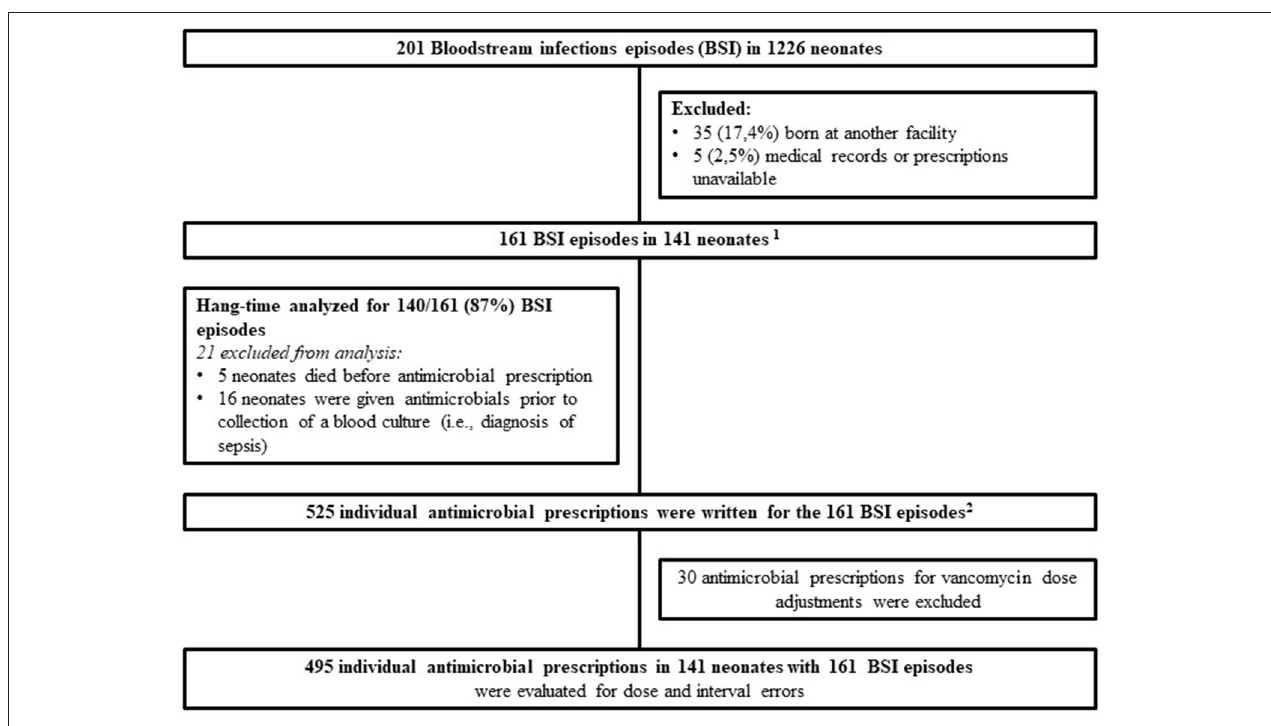
FIGURE 1 | Culture confirmed blood stream infection episodes and prescriptions in very low birth weight neonates from 1 July 2018 to 31 December 2019. 1 141 neonates: 15 with 2 BSI episodes, 1 with 3 BSI episodes and 1 with 4 BSI episodes. 2 Missed and delayed doses were evaluated on all 525 prescriptions with the denominator being the total number of doses